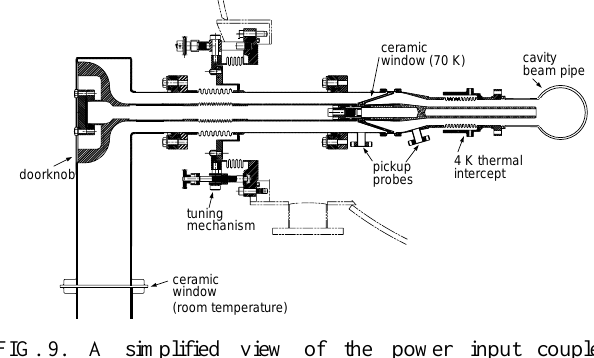
FIG. 9. A simplified view of the power input coupler version